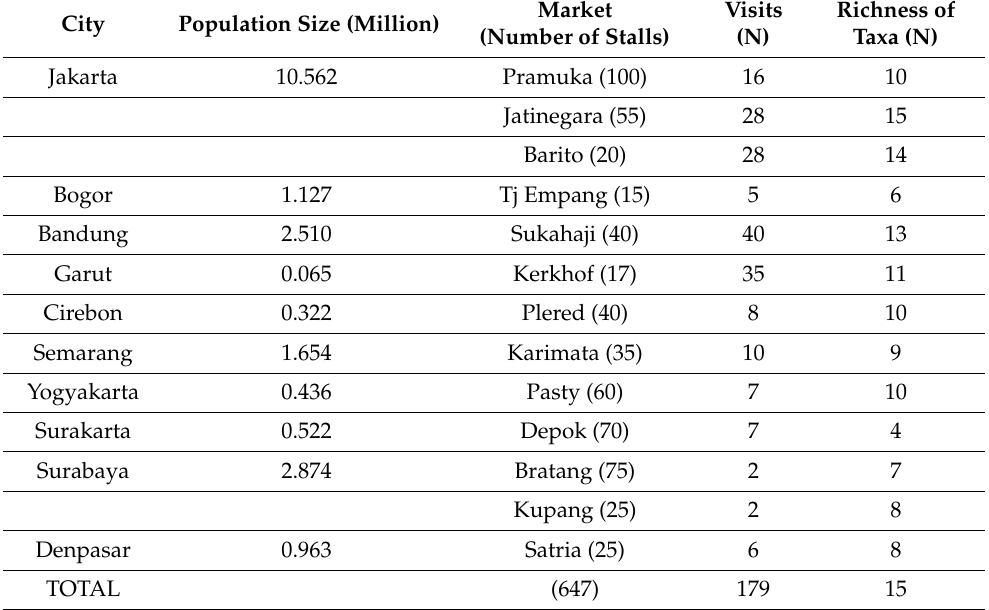
Table 1. Details on location (city) with population size, names of the markets sampled, the sample size in number of visits to the market, number of stalls, and richness of mammalian taxa sold in each of the 14 wildlife markets surveyed in Indonesia (Java and Bali). Cities are listed from west to east. Market Visits Richness of City Population Size (Million) (Number of Stalls) (N) Taxa (N) Jakarta 10.562 Pramuka (100) 16 10 Jatinegara (55) 28 15 Barito (20) 28 14 Bogor 1.127 Tj Empang (15) 5 6 Bandung 2.510 Sukahaji (40) 40 13 Garut 0.065 Kerkhof (17) 35 11 Cirebon 0.322 Plered (40) 8 10 Semarang 1.654 Karimata (35)